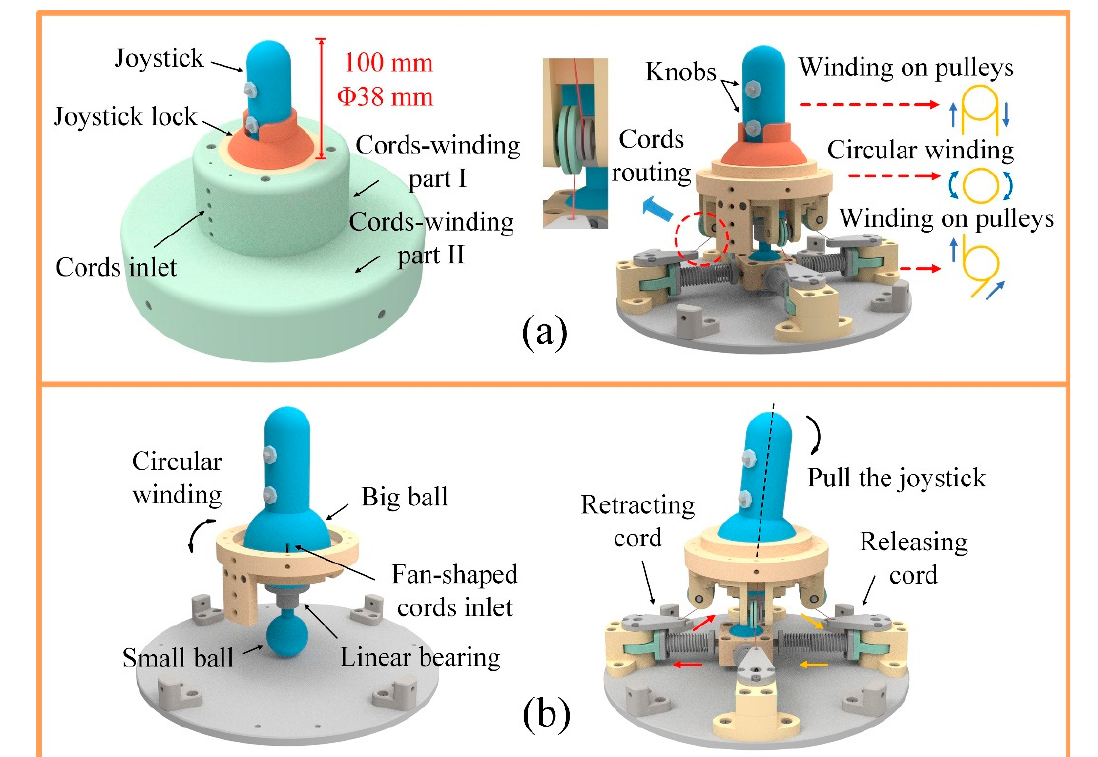
Figure 6. Schematic diagram of the controller structure: ( a ) schematic diagram of the cords routing in the controller; ( b ) design of control structure for the bending movement of surgical instruments.